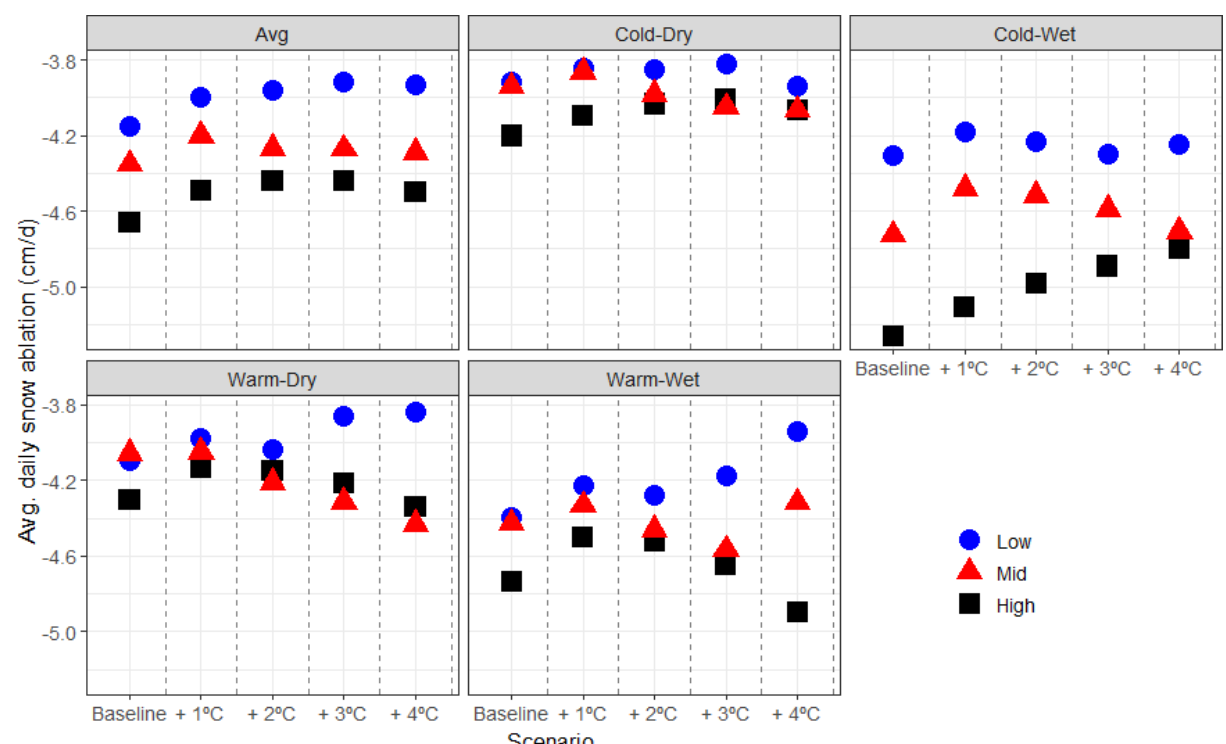
Figure 7. Absolute snow ablation values (centimeter per day) ( y axis) at three different elevations during four different compound tempera- tures and precipitation for the baseline and different increments of temperature ( x axis)